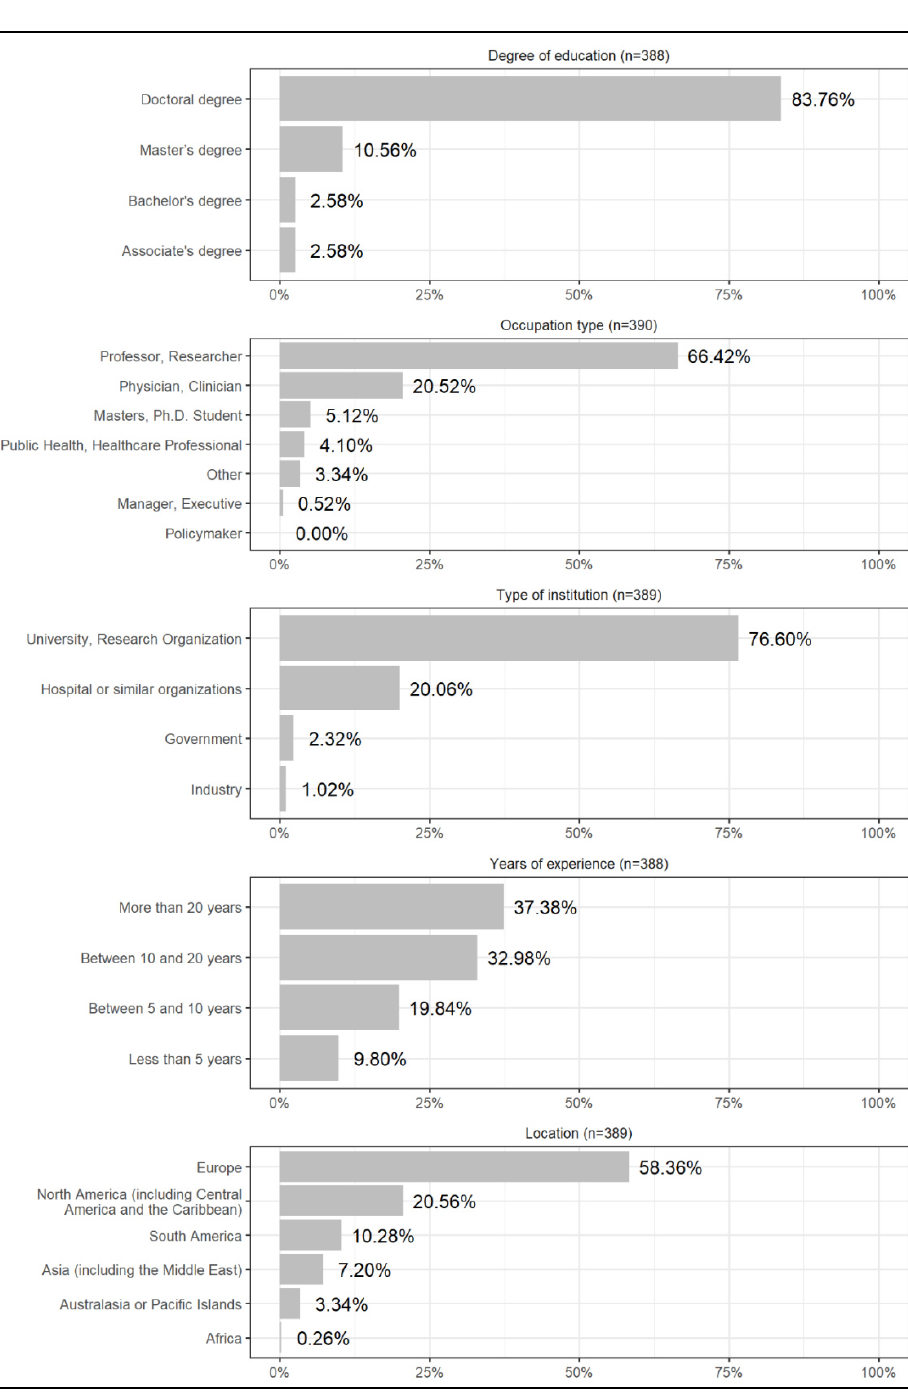
Figure 1. Demographic profile of the respondents.